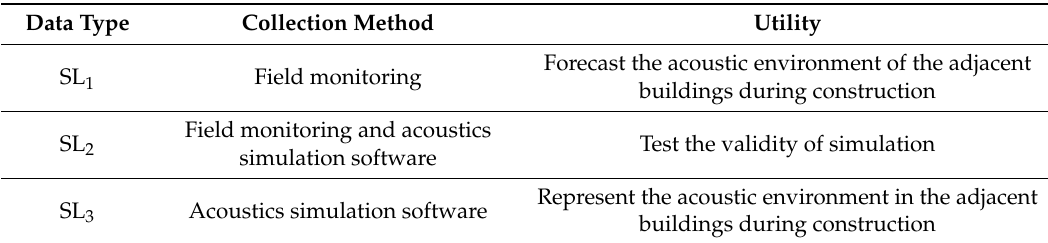
Table 4. Description of the